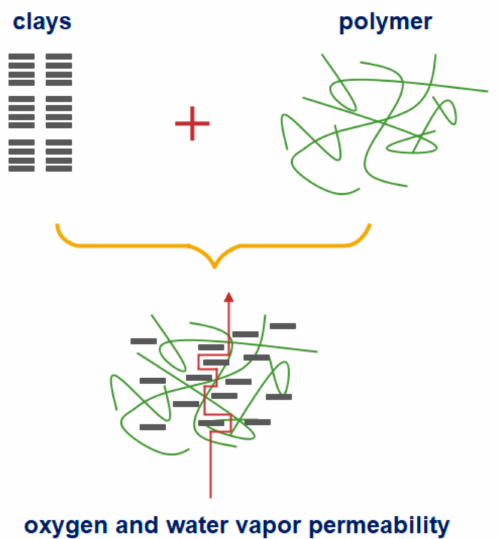
Figure 5. Nonlinear and prolonged pathway of oxygen and water vapor permeability formed due to the incorporation of clay into a polymer matrix film